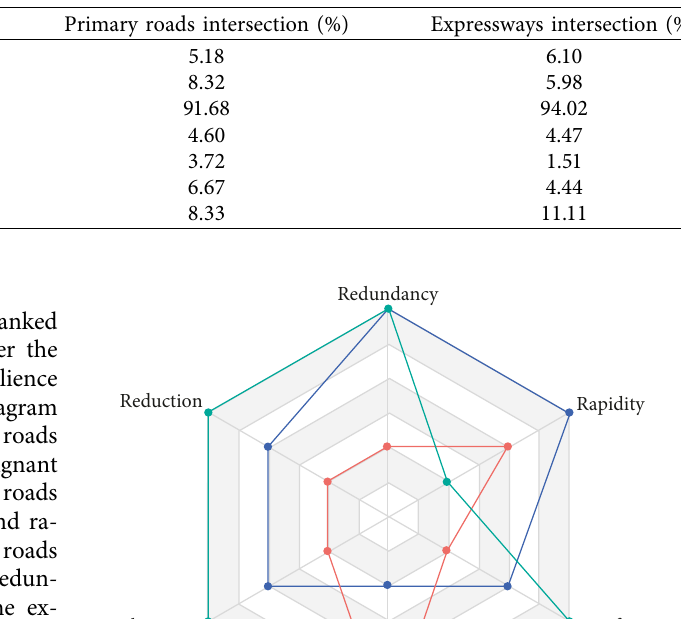
Table 2: Values of “6R” under three scenarios of malignant traffic accidents.